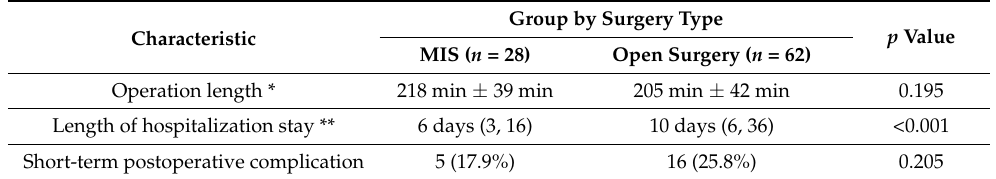
Table 2. Comparison of laparoscopy and laparotomy features for RH.